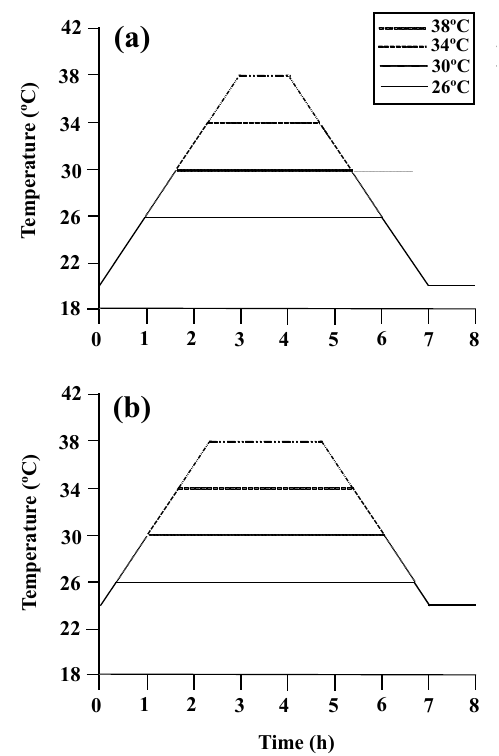
Figure A1. Diagram of the heating protocol for (a) limpets accli- mated at 20 ◦ C and (b) limpets acclimated at 24 ◦ C. Limpets were heated at a rate of 6 ◦ Ch − 1 from acclimation temperatures (20 or 24 ◦ C) to designated temperatures (26, 30, 34, and 38 ◦ C) for sim- ulating a natural heating rate in summer. After achieving the target temperature, the temperature was held at the designated level for the allotted time and then decreased to acclimated temperatures (20 or 24 ◦ C) at a rate of 6 ◦ Ch − 1 , for a total exposure time of 7h. After recovery in 20 or 24 ◦ C seawater for 1h, limpets ( n = 8–10) in each treatment were immediately collected and stored at − 80 ◦ C for gene expression measurement.